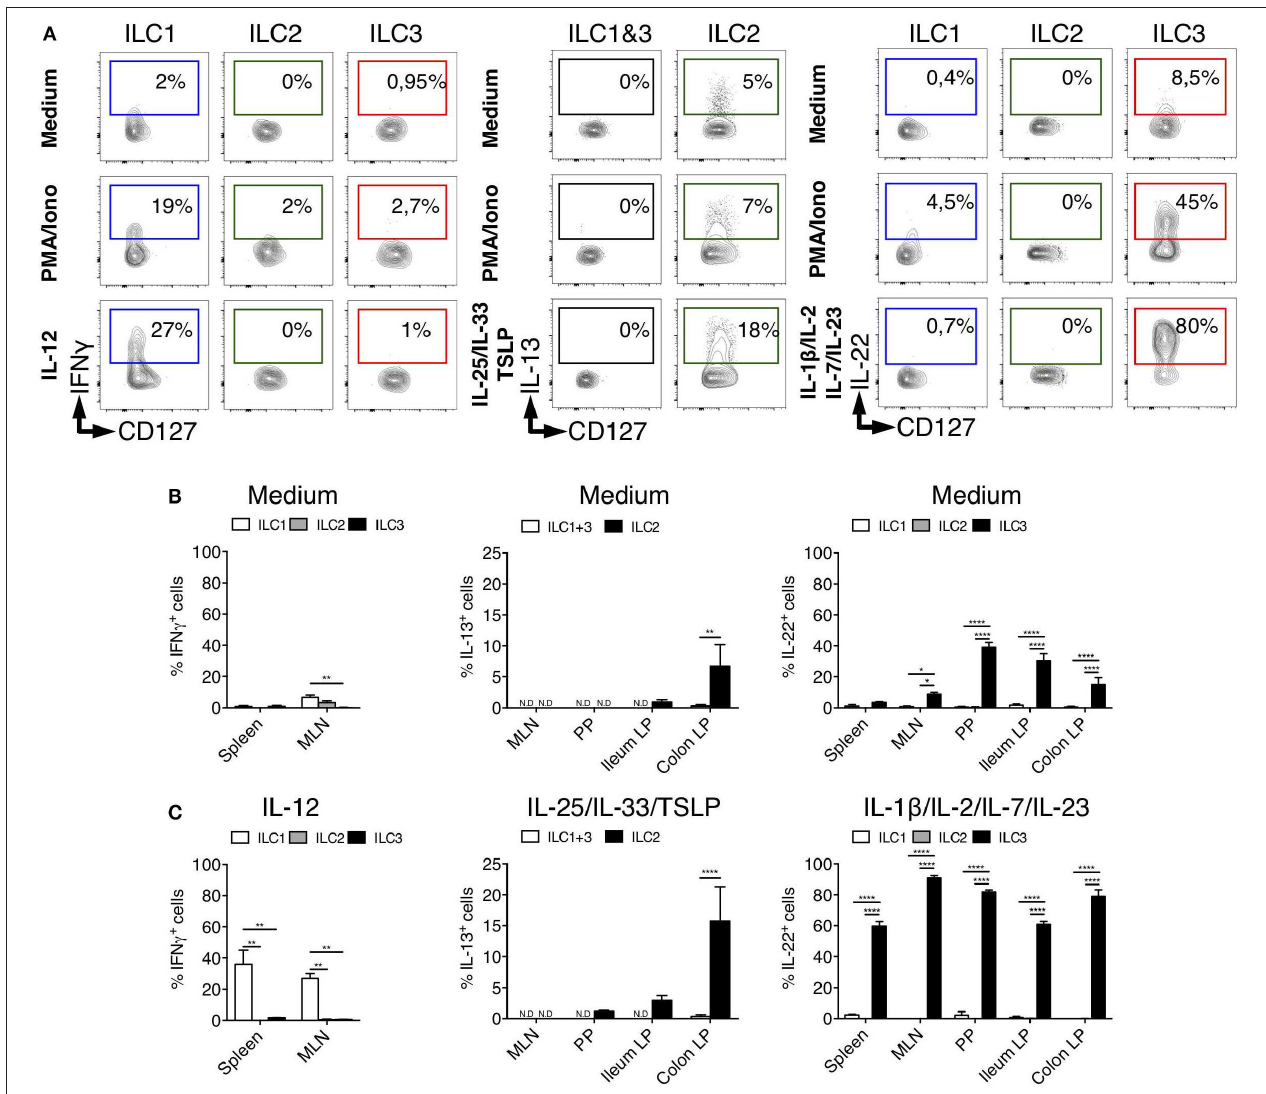
FIGURE 3 | Tissues quantification of cytokine production by ILC subsets in rats. (A) Representative intracellular staining for IFN γ (in spleen from LEW rats), IL-22 and IL-13 (in Colon LP from SPD rats) in ILC subsets as defined in Figure 1A after 4h of culture in the absence (medium) or the presence of PMA/Ionomycin or IL-12, a cocktail of IL-25, IL-33, and TSLP or a cocktail of IL-1 β , IL-2, IL-7, and IL-23. Flow cytometry quantification of cytokine-producing cells among ILC subset in the depicted tissues after 4h of culture in the absence (B) or the presence (C) of indicated cytokine cocktails. Data are representative of 2 (PMA + ionomycin) to 6 (cytokines) independent experiments, numeric data represents means ± SEM, ND, not detected. * p < 0.05, ** p < 0.01, **** p <